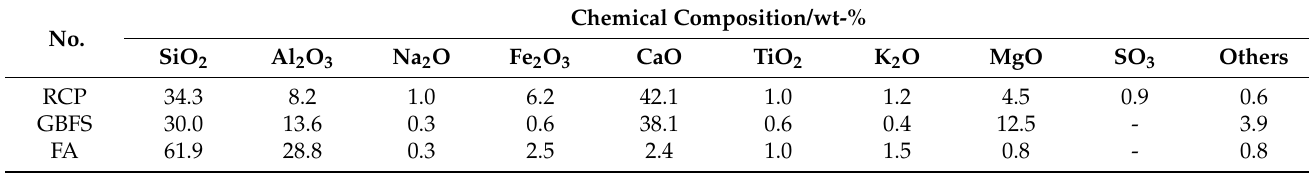
Table 1. Chemical composition of RCP, GBFS and